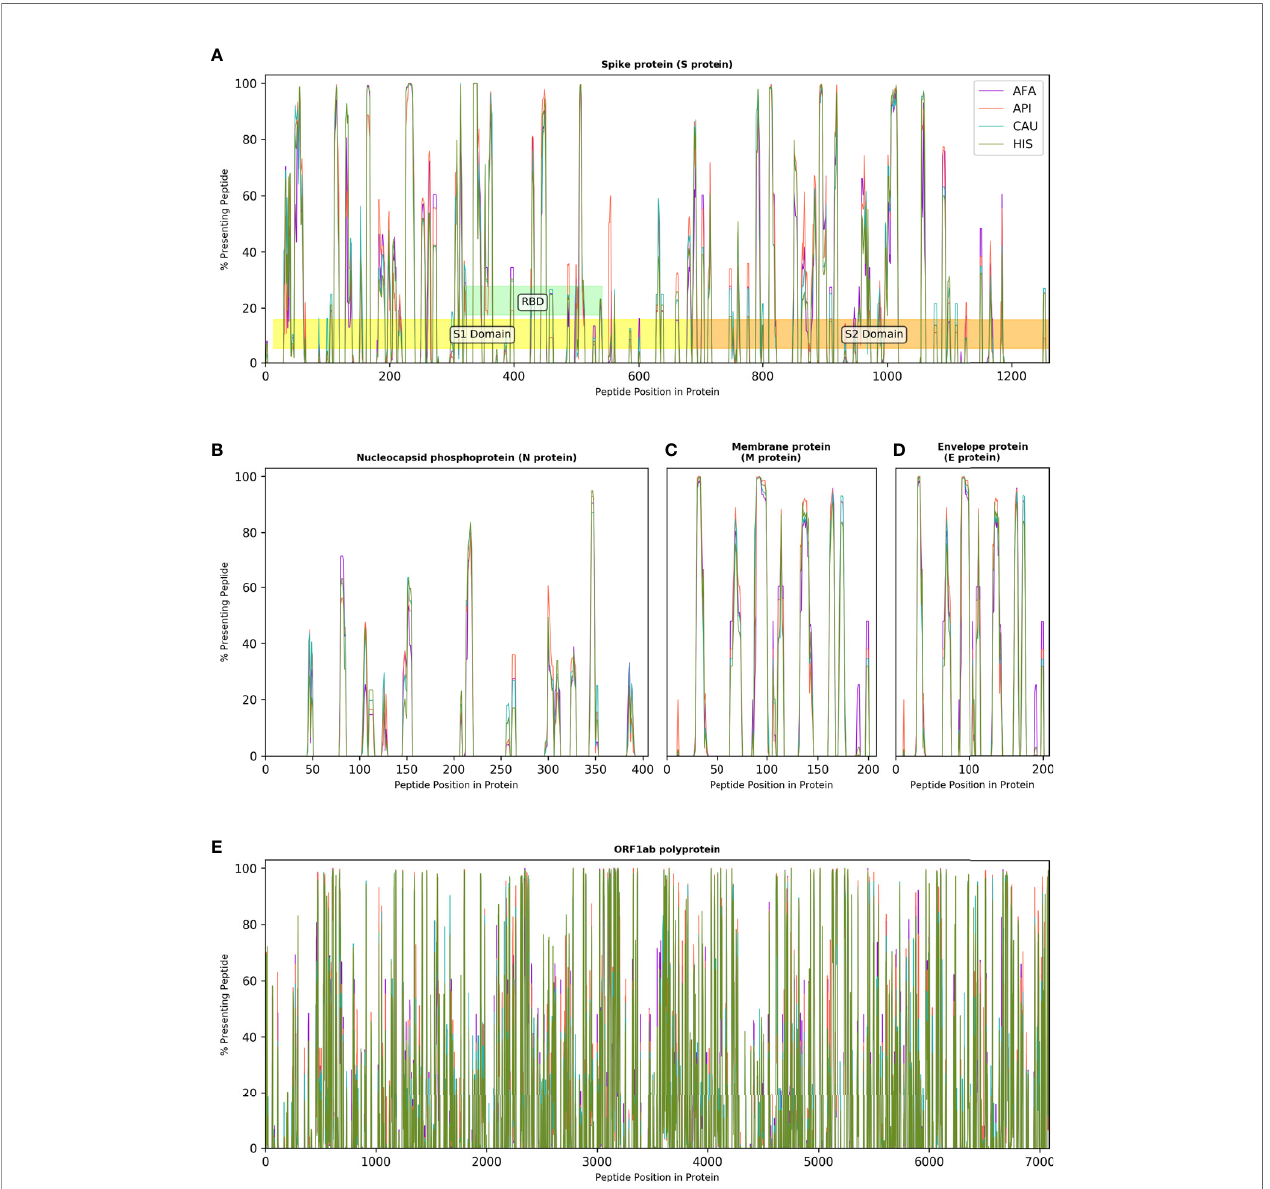
FIGURE 4 | Immunogenicity maps of SARS-CoV-2 proteome at the population level. The panels depict the percentage of HLA class II genotypes, within populations of 10,000 individuals (AFA, African Americans; API, Asian Paci fi c Islanders; CAU, Caucasians and HIS, Hispanics), that are predicted to present individual SARS-CoV-2 peptides from (A) . Spike protein (S protein), S1, S2 and Receptor Binding Domain (RBD) are also shown; (B) . Nucleocapsid protein (N protein); (C) . Membrane protein (M protein); (D) . Envelope protein (E protein); and (E) . Open Reading Frame (ORF) 1ab